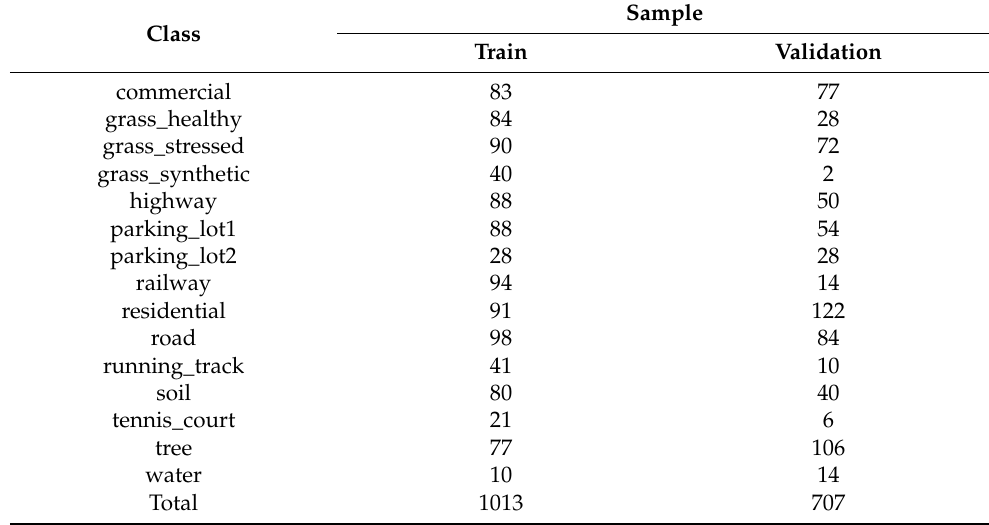
Table 1. Summary of training and validation samples of Houston dataset.